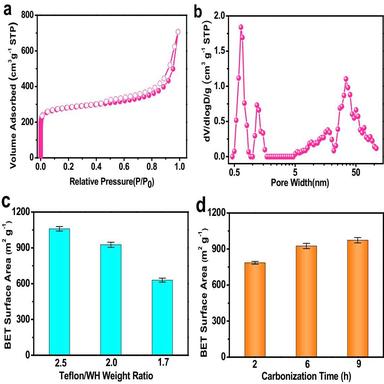
(a) N2 adsorption-desorption isotherm and (b) pore size distribution curve of NNSC-1. BET surface areas of NNSCs obtained at various (c) Teflon/WH weight ratios and (d) carbonization times. Error bars represent the standard deviation of triplicate experiments.